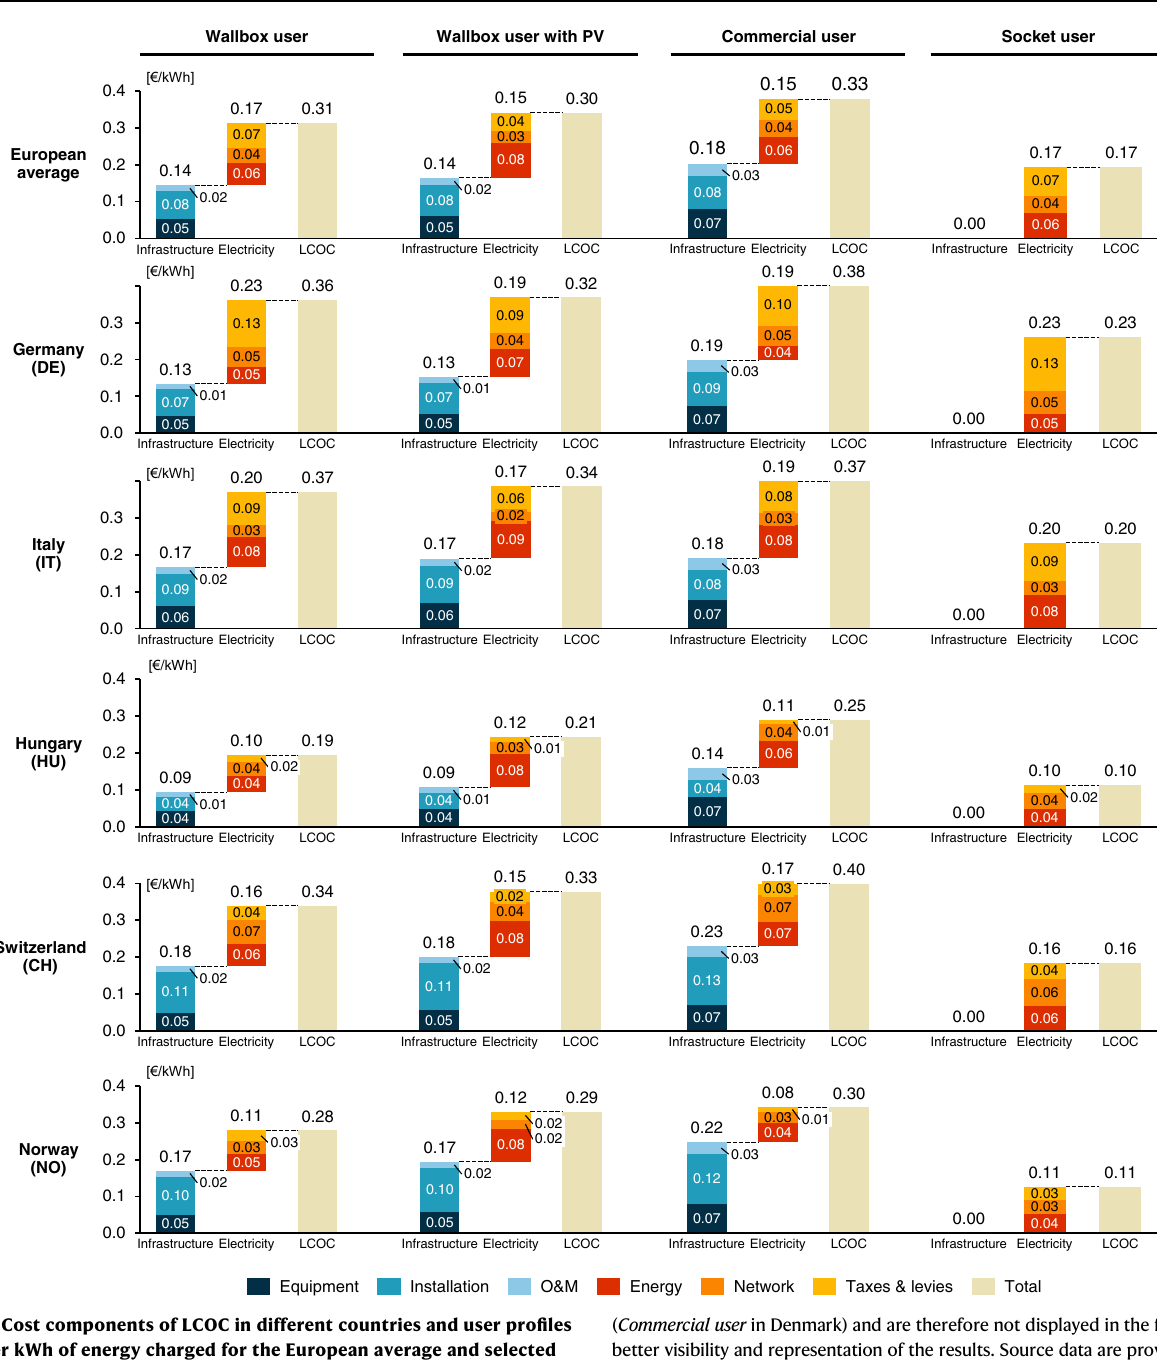
Fig. 4 | Cost components of LCOC in different countries and user pro fi les in € per kWh of energy charged for the European average and selected countries. Note that transaction costs amount to 0.004 € kWh − 1 at most